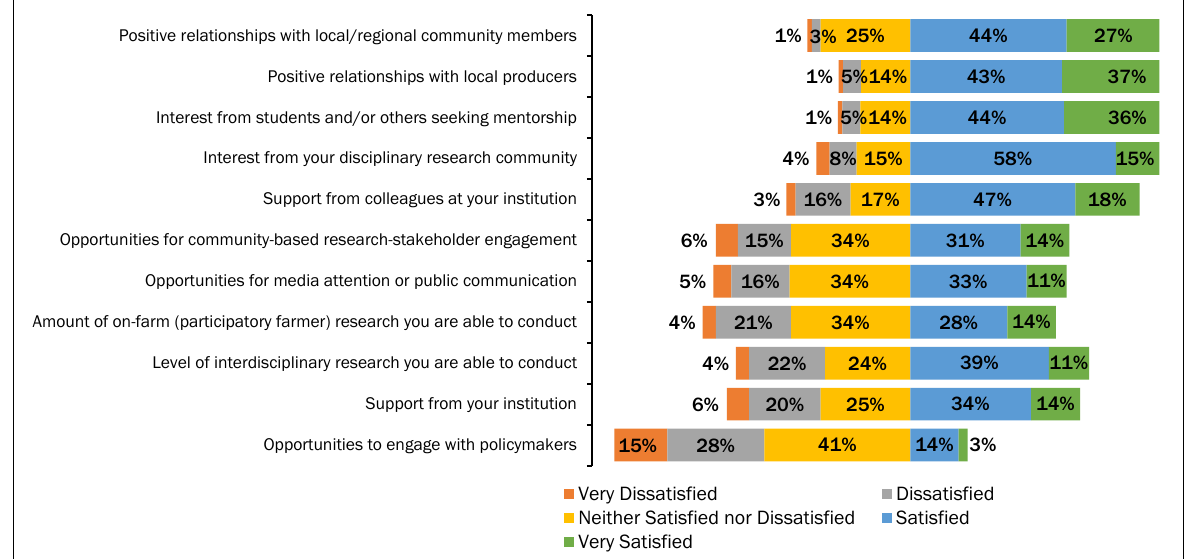
Figure 2. Level of Satisfaction in Areas of Sustainable Agriculture Research